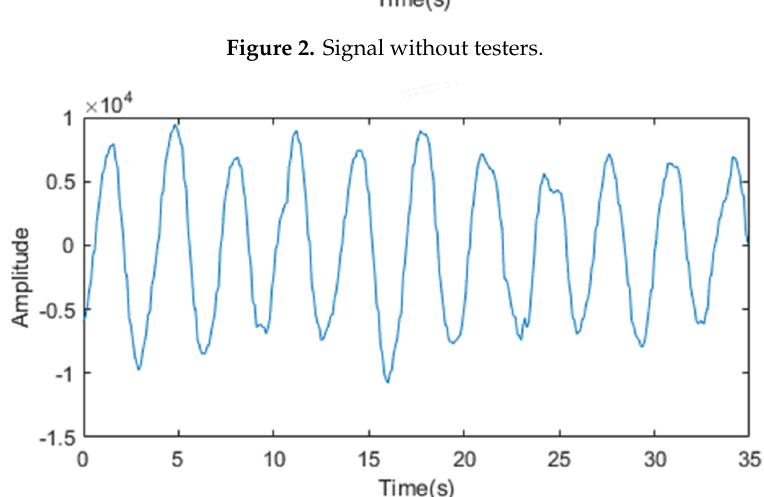
Figure 4. Tester’s signal when holding their breath. Through the above tests, it is noted that the Doppler radar module is used to detect human respiratory signals. As for the heartbeat signal, several experiments have shown that the heartbeat signal is very weak and is basically covered by noise, such that the Doppler radar module cannot detect the heartbeat signal. Instead, the smart bracelet is used for heart rate collection. The experiment recruited 7 drivers as experimental test subjects, including 6 men and 1 woman, aged between 22 and 30 years old. It requires good health, normal hearing and vision, and no red–green color blindness. Before the experiment, the tester is required to ensure sufficient sleep time. After the debugging of the whole experimental platform, the test personnel will conduct simulated driving, and each test period will last for 3 h. Throughout the three-hour test, the tester will experience different fatigue states. The Doppler radar module and the smart bracelet collect respiratory and heartbeat signals, and synchronizes video signals to record facial features. At the end of each test, a data set containing respiration and heartbeat signals and corresponding video signals will be obtained through each test. The entire data set will be used for the next expert’s review before classification into different fatigue levels. 3. Sample Library In Section 2, the data are classified through the facial expert evaluation method. This method was first introduced to the driver’s fatigue assessment and becomes the most practical method for evaluating the fatigue state of drivers [41]. The specific operation procedure is as follows. Firstly, the